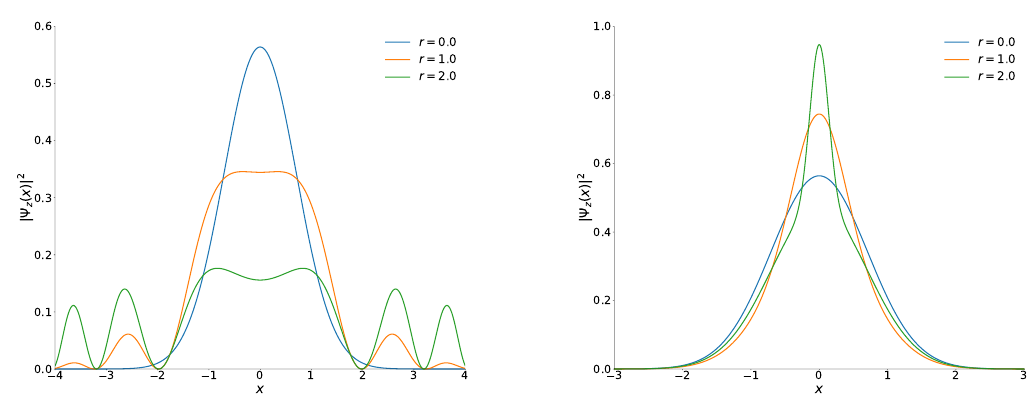
Figure 1. The probability density Equation (34) of EVSS for different values of the squeezing parameter r . Left : θ = π /2. Right : θ =